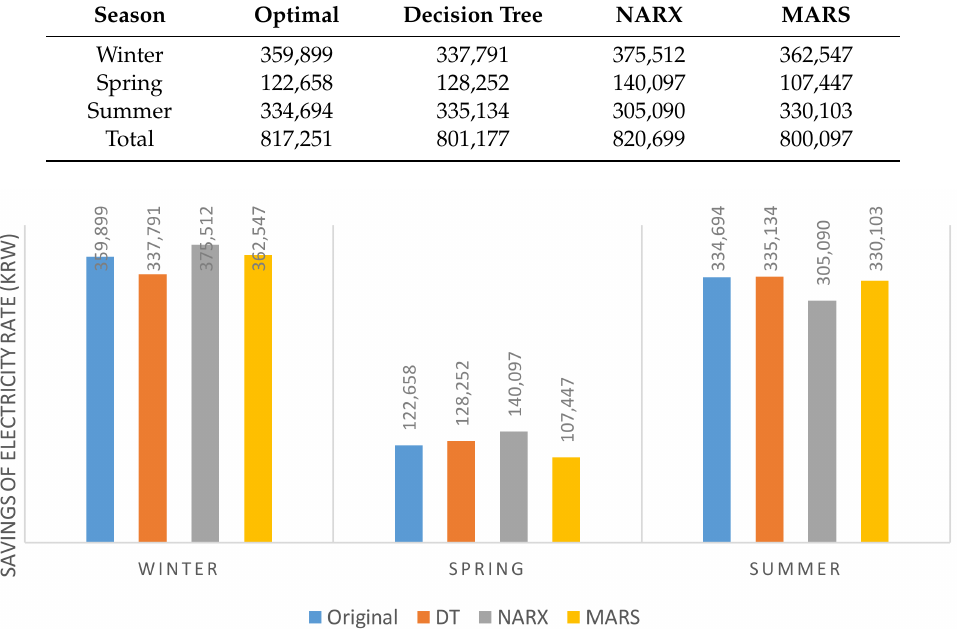
Table 4. Savings of Electricity Rate (KRW).